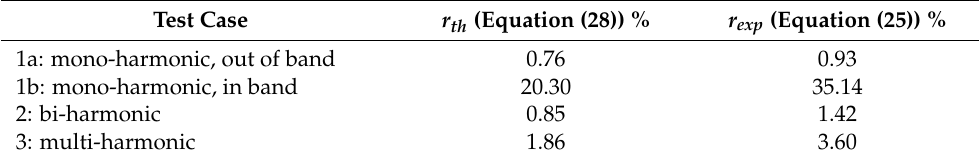
Table 3. RMS values for dynamic errors in the three test